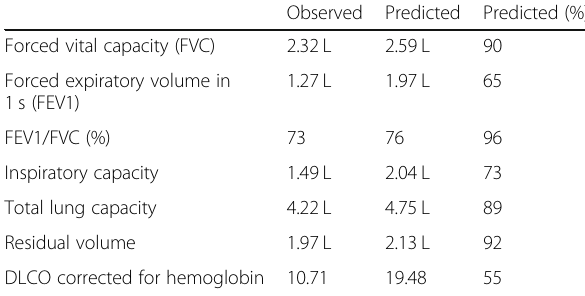
Table 1 Selected pulmonary function test results Observed Predicted Predicted (%)